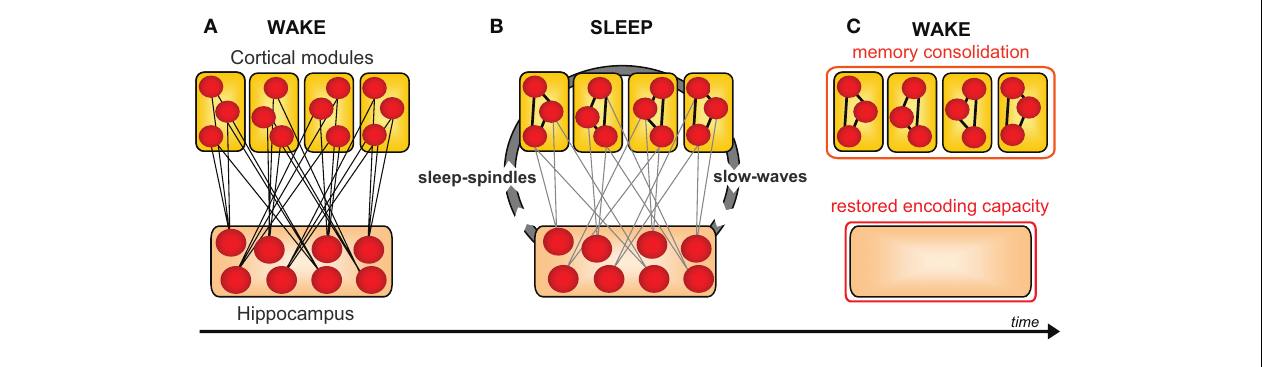
hippocampal-cortical network leads to progressive strengthening of cortico-cortical connections, (C) which over time, allow these memories to become independent of the hippocampus and gradually integrated with pre-existing cortical memories. Modified from Frankland and Bontempi, 2005.